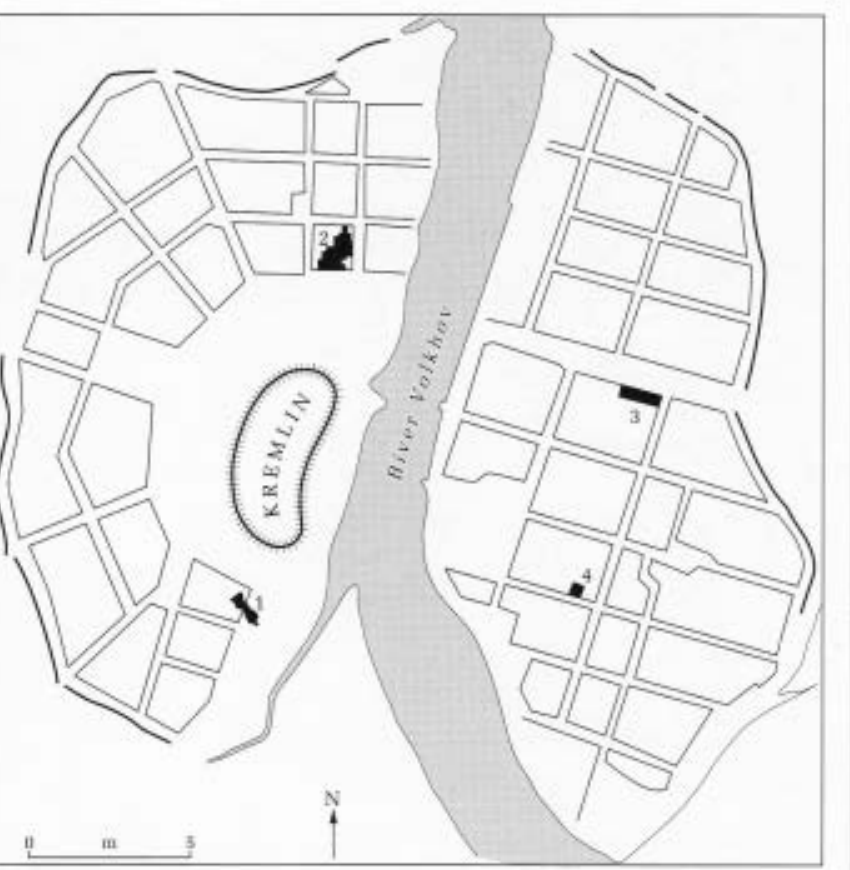
Figure 2 Plan of Novgorod, showing the locations of the excavations mentioned in the text: Troitsky ( 1) Nerevsky (2) Fyodorovsky(3) Duboshin ( 4) (based on Fig. 1.1 in Brisbane (ed.) (seen.